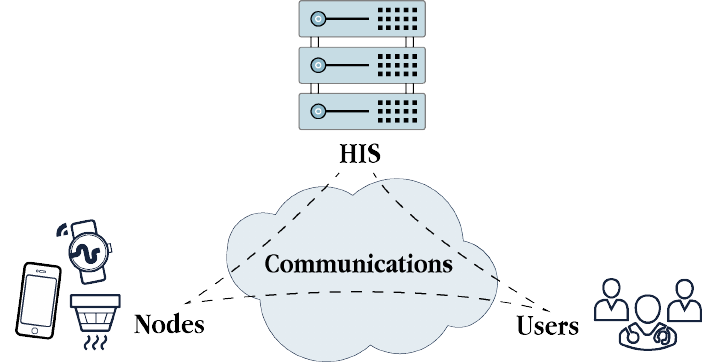
Figure 4. Relationship among the actors involved in smart healthcare